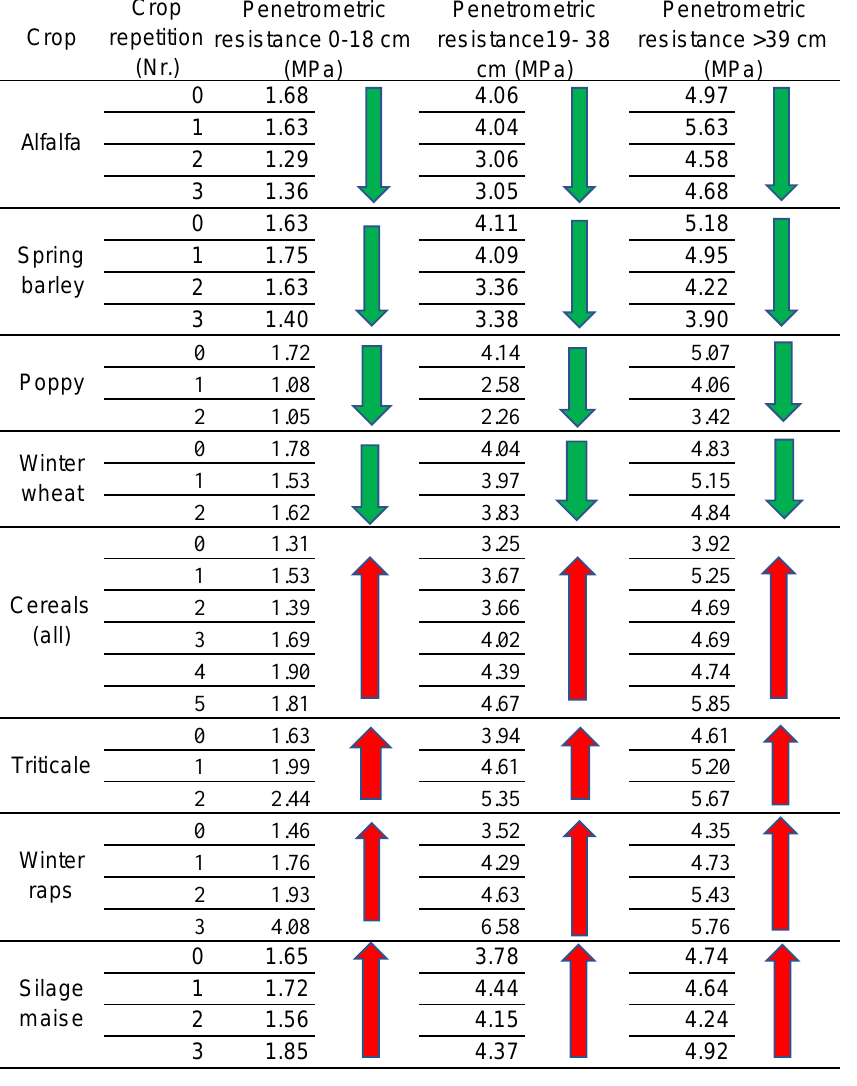
Figure 6. The penetrometric resistance according to the number of crop repetitions depending on the depth of the soil.